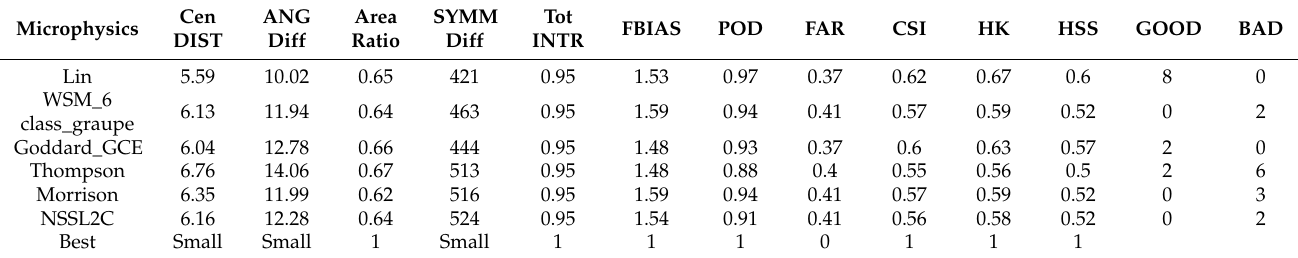
Table A1. Mode analysis using PERSIANN-CDR satellite-based data.